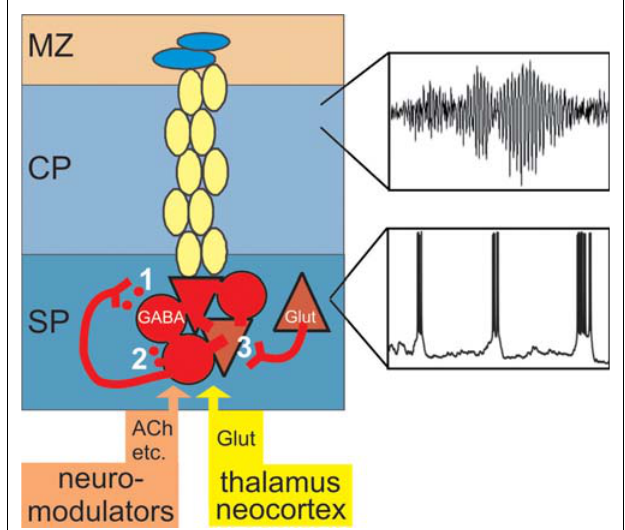
FIGURE 8 | Amplifi cation of afferent and intracortical activity by the subplate. During early cortical development the subplate receives a transient and selective synaptic input from neuromodulatory systems, from the sensory periphery via specifi c thalamic nuclei and via corticocortical fi bers from other neocortical areas. Subplate cells are capable to fi re repetitive action potentials (Figure 3A) and upon activation of cholinergic postsynaptic receptors discharge in repetitive bursts (lower inset and Figure 5 ). GABAergic subplate neurons release GABA in an activity-dependent (1) and tonic (2) manner thereby inducing a postsynaptic excitatory response. Glutamatergic subplate neurons boost neuronal network activity in the 10–40 Hz frequency range. Subplate neurons are not only coupled via these excitatory synaptic circuits, but also via gap junctions (Figure 2) . Chemical and electrical synapses contribute to the generation of subplate-driven oscillatory activity which is transmitted to the gap junctional coupled network in the cortical plate (Figure 2A) and marginal zone and induces 10–20 Hz neocortical network oscillations (upper